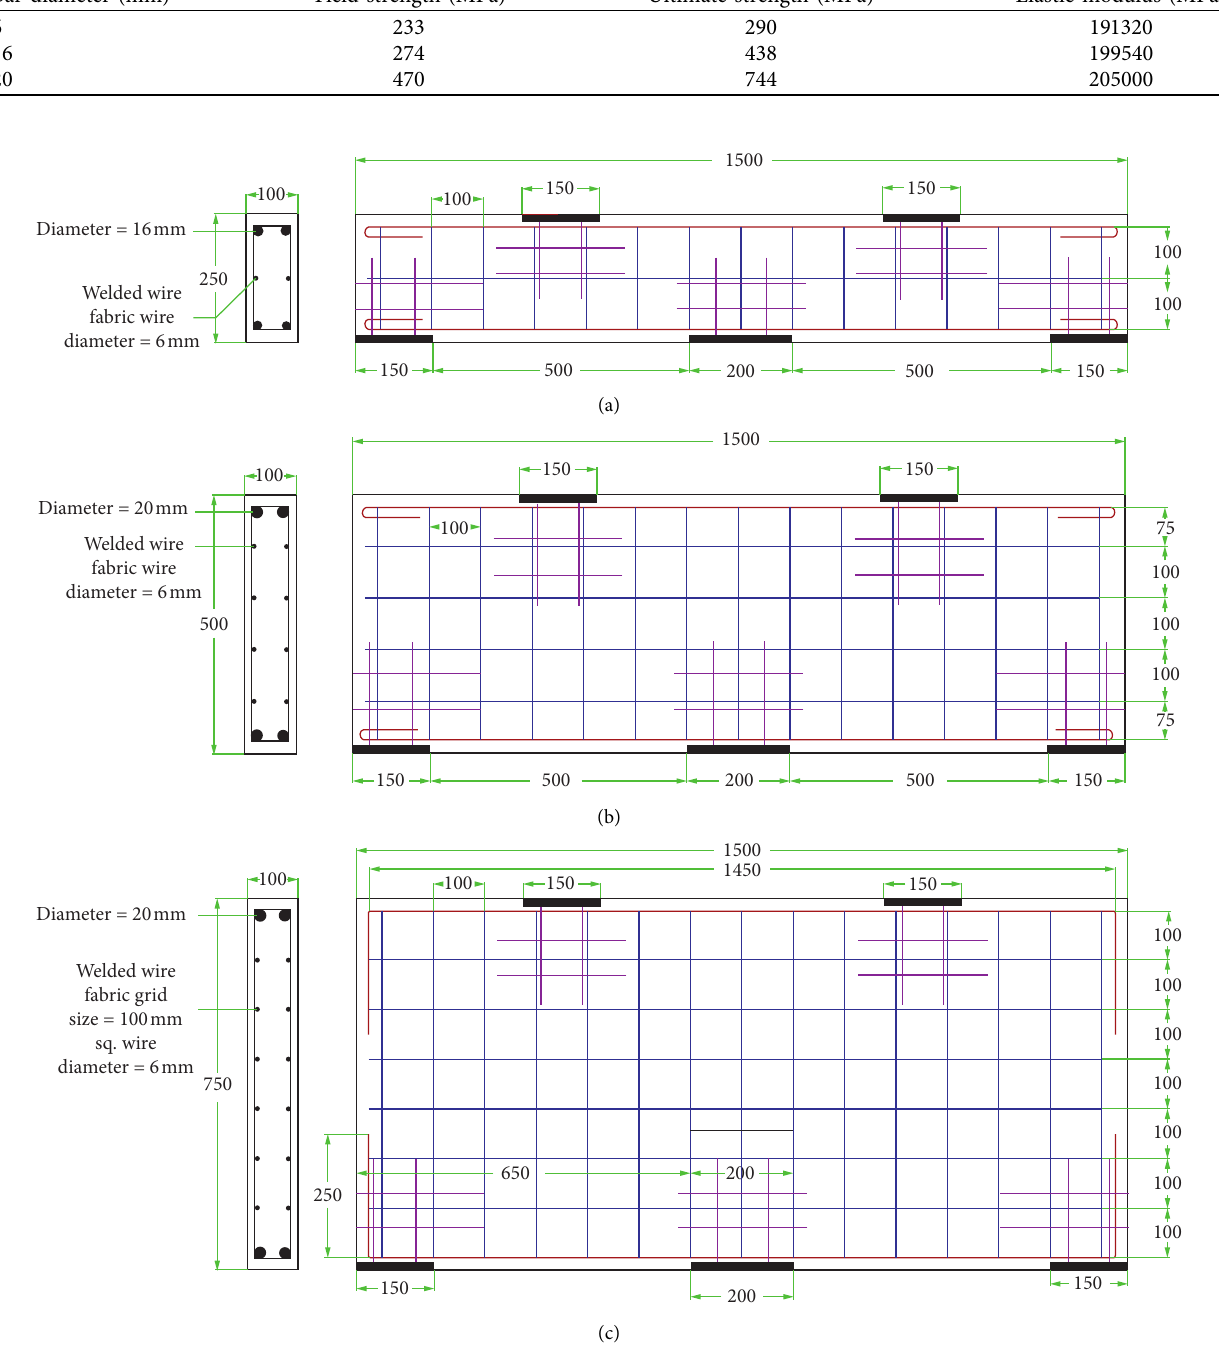
Figure 1: Details of reinforcing bars in beams. (a) BT1. (b) BT2. (c)